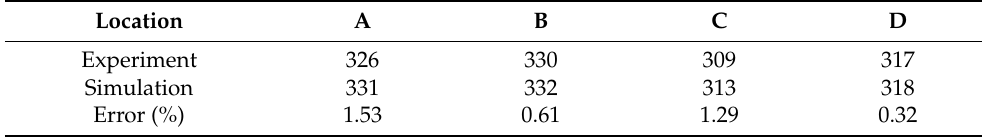
Figure 7. ( a ) Test setup and ( b ) test point of the heat dissipation performance.